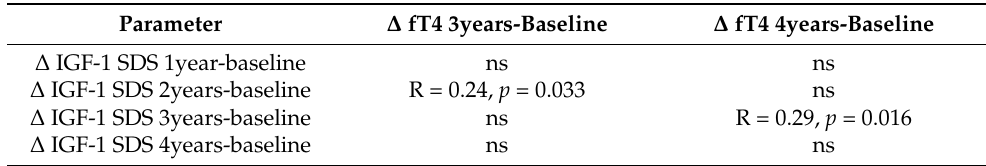
Table 3. Associations between changes ( ∆ ) in fT4 levels in the first three and four years of rhGH therapy and changes in IGF-1 SDS values after the initiation of